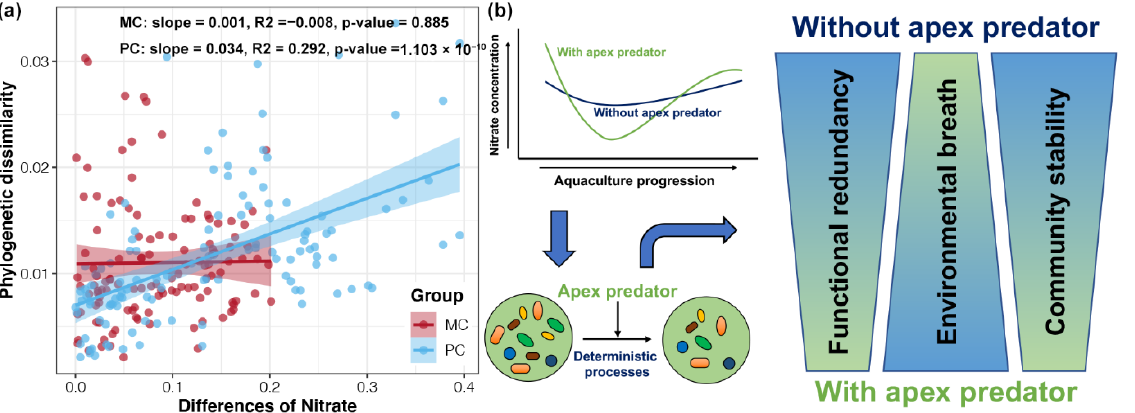
Figure 6. Mechanisms of apex predators’ shaping of bacterioplankton communities. ( a ) Linear regression analysis of differences in nitrate concentrations and phylogenetic dissimilarities for bacterioplankton in MC and PC ponds. ( b ) Conceptual models revealing the mechanism of bacterioplankton variation in aquaculture ponds affected by apex predator disturbance.